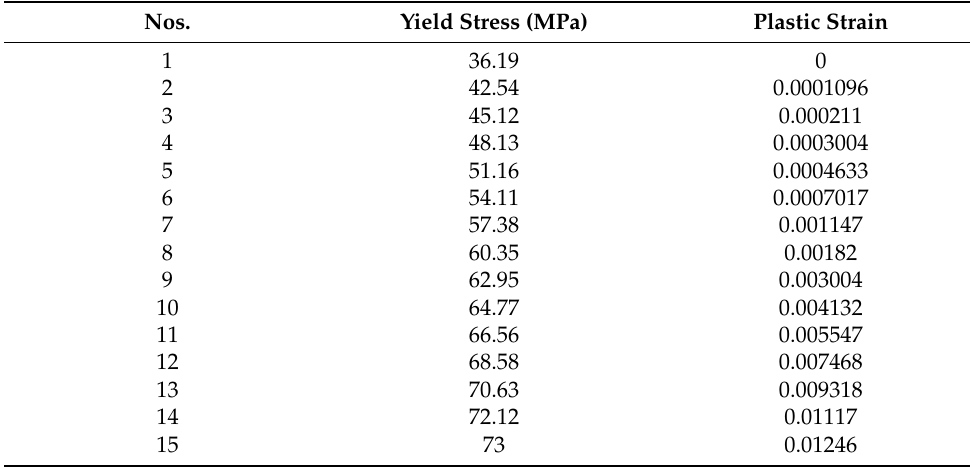
Table A1. Yield stress and plastic strain of aluminum foil.